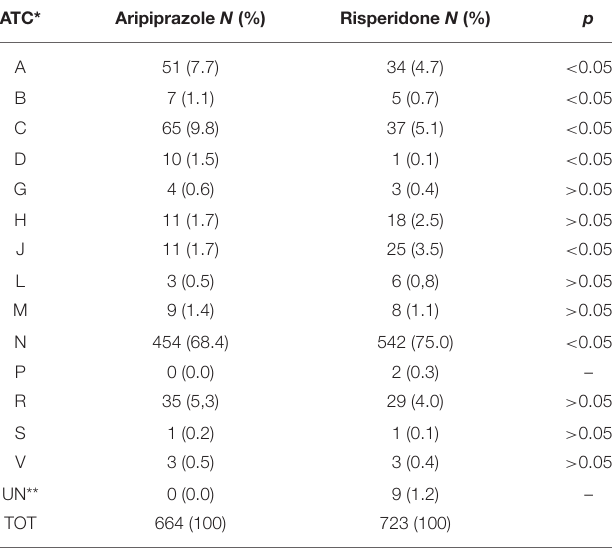
TABLE 9 | Distribution of other concomitant drugs reported with aripiprazole and risperidone grouped according to the Anatomical Therapeutic Chemical (ATC) classification system I